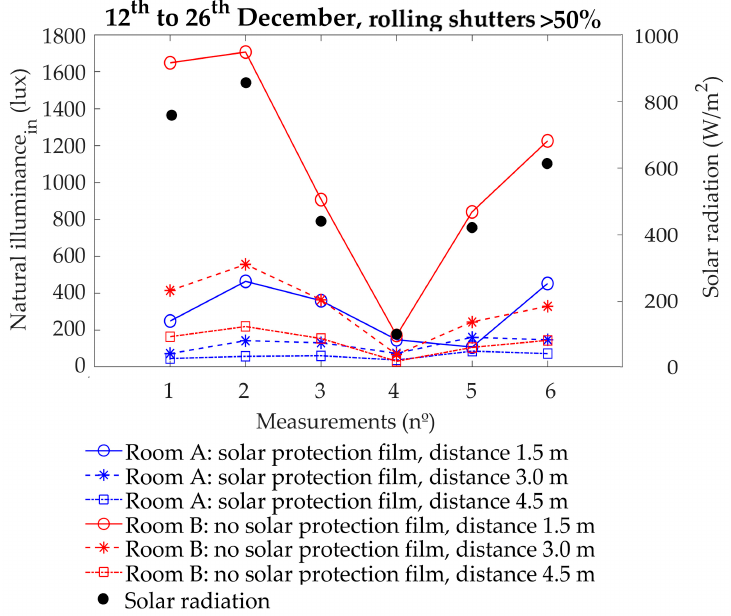
Figure 7. Incident solar radiation and indoor natural illuminance recorded in the room without solar film (red points) and with solar film (blue points), according to the distance between the luxmeter and the window. Winter period. Source: Authors.